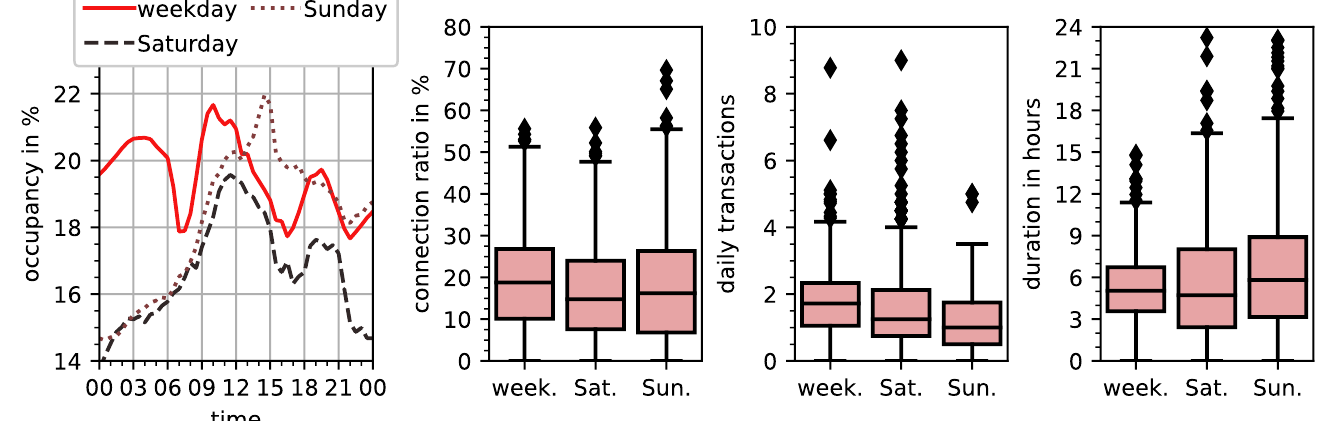
Figure 7. Overview of the general charging station usage in